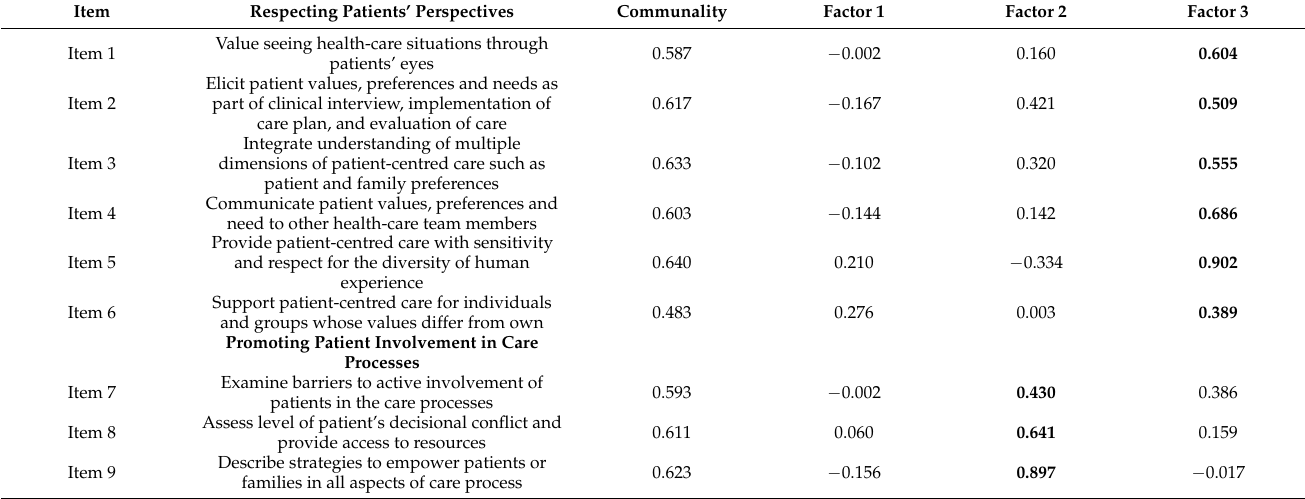
Table 2. Exploratory factor analysis (EFA) Pattern matrix, Dataset I (n = 223), items of competence in the